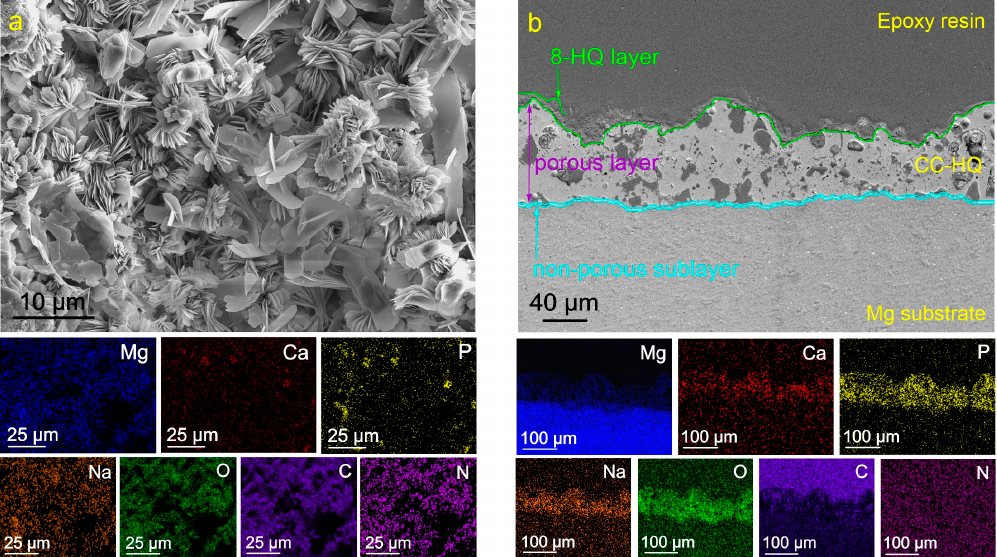
Figure 2. SEM images of the surface ( a ) and cross-section ( b ) of the CC-HQ-coated samples and maps of elements distribution over the sample’s surface ( a ) and thickness ( b ).